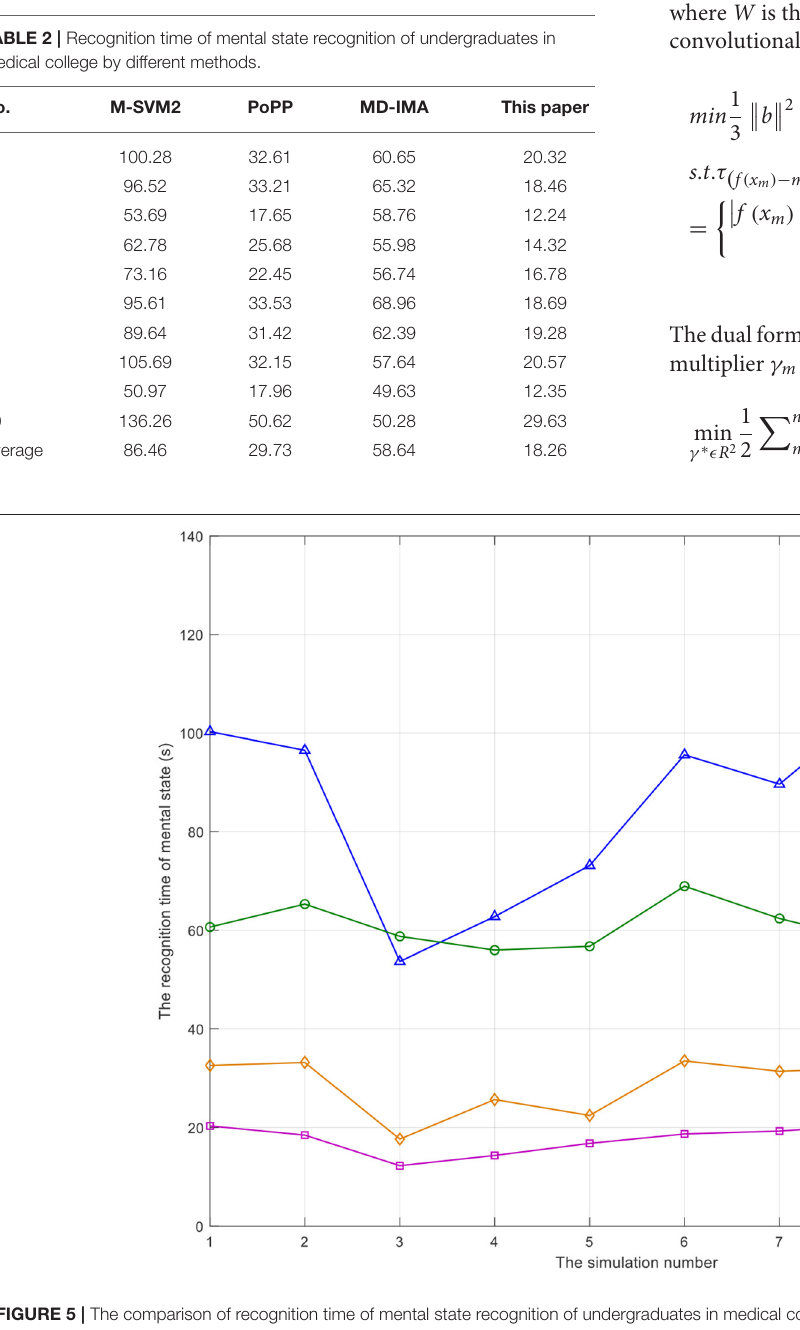
Frontiers in Public Health |